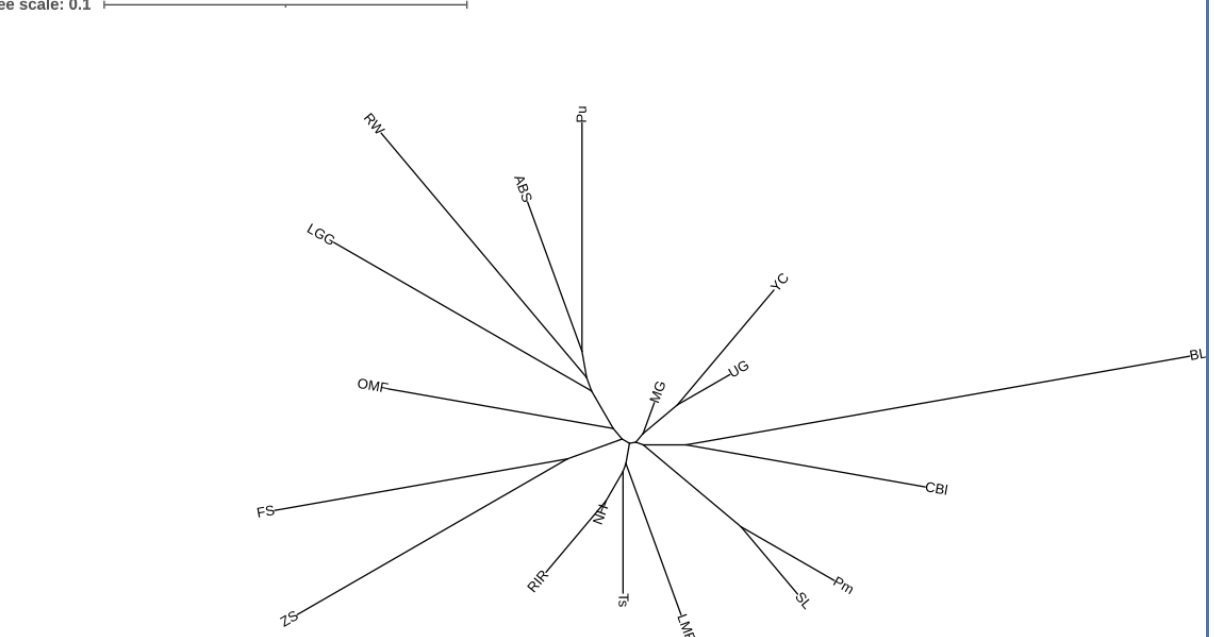
Figure 3. Phylogenetic tree for 18 chicken breeds based on SNP genotypes and pairwise F ST genetic distances (Supplementary Table S3) plotted using the Neighbor-Net method (in the SplitsTree 4 program) and the iTOL v. 5 web service [59]. The corresponding Newick tree format is shown in Supplementary Information S2.